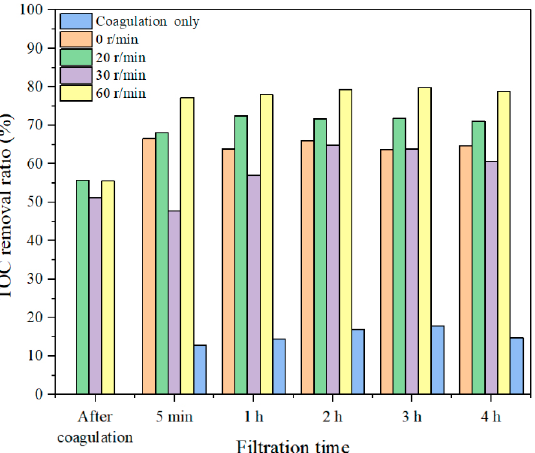
Figure 11. TOC removal ratios with 30 mg/L coagulant and different rotation speeds in SA solution.